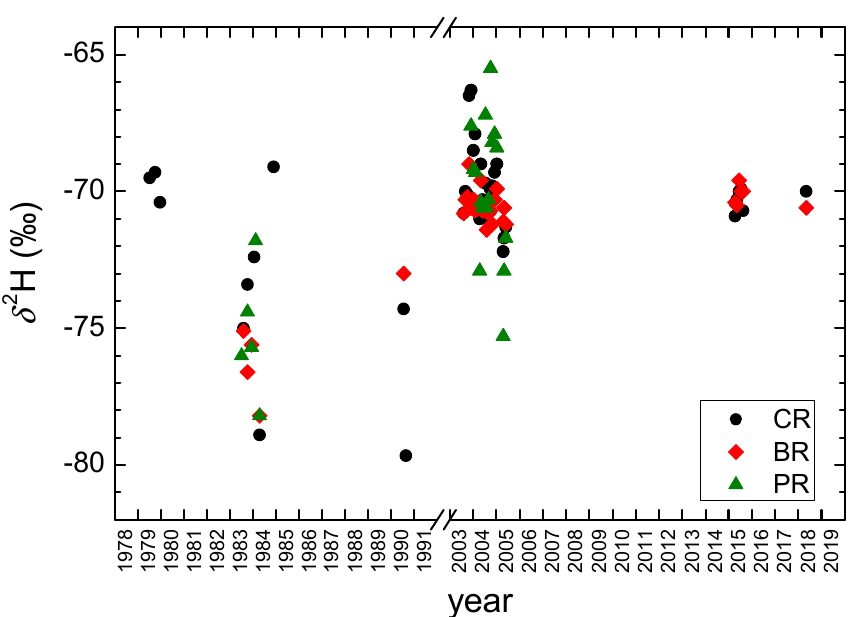
Figure 10. The δ 2 H values in groundwater (CR, BR, and PR springs), 1978–2019. Note the break between 1991 and 2003.